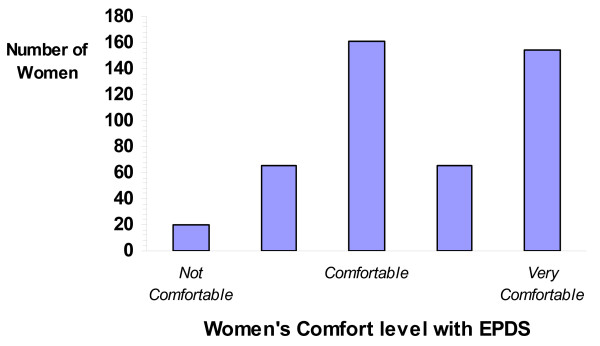
Distribution of responses on a 5-point Likert scale of comfort level in being screened with the EPDS.